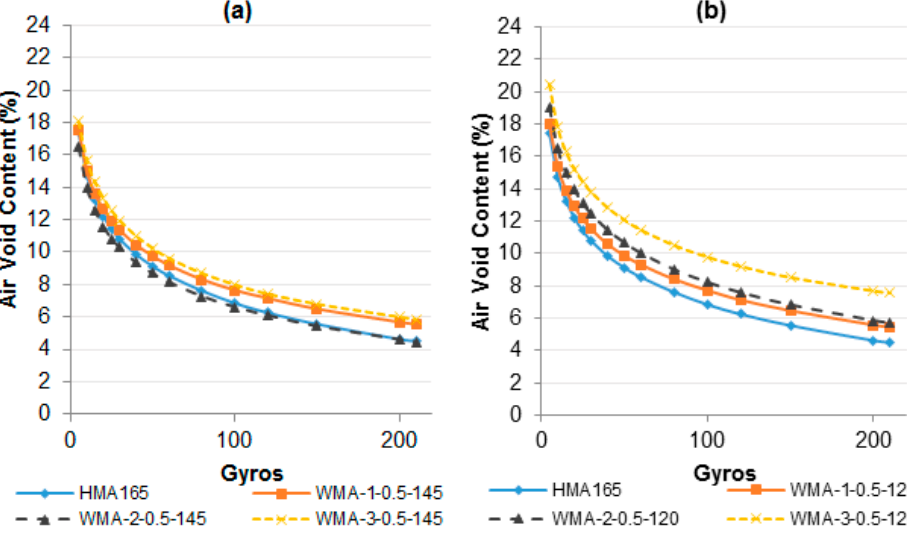
Figure 1. Densification curves of the mixtures with various additives and different manufacturing temperatures. ( a ) 145 ◦ C vs. 165 ◦ C; ( b ) 120 ◦ C vs. 165 ◦ temperatures. ( a ) 145 °C vs. 165°C; ( b ) 120°C vs. 165°C.